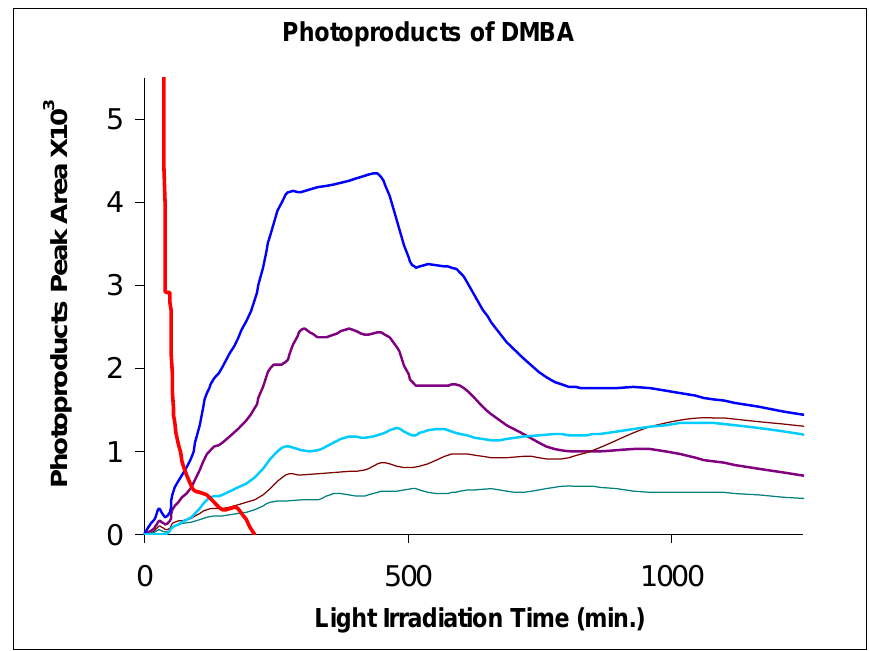
Figure 6: Time course of photodecomposition of DMBA and formation and photodecomposition of the identified DMBA photodecomposition